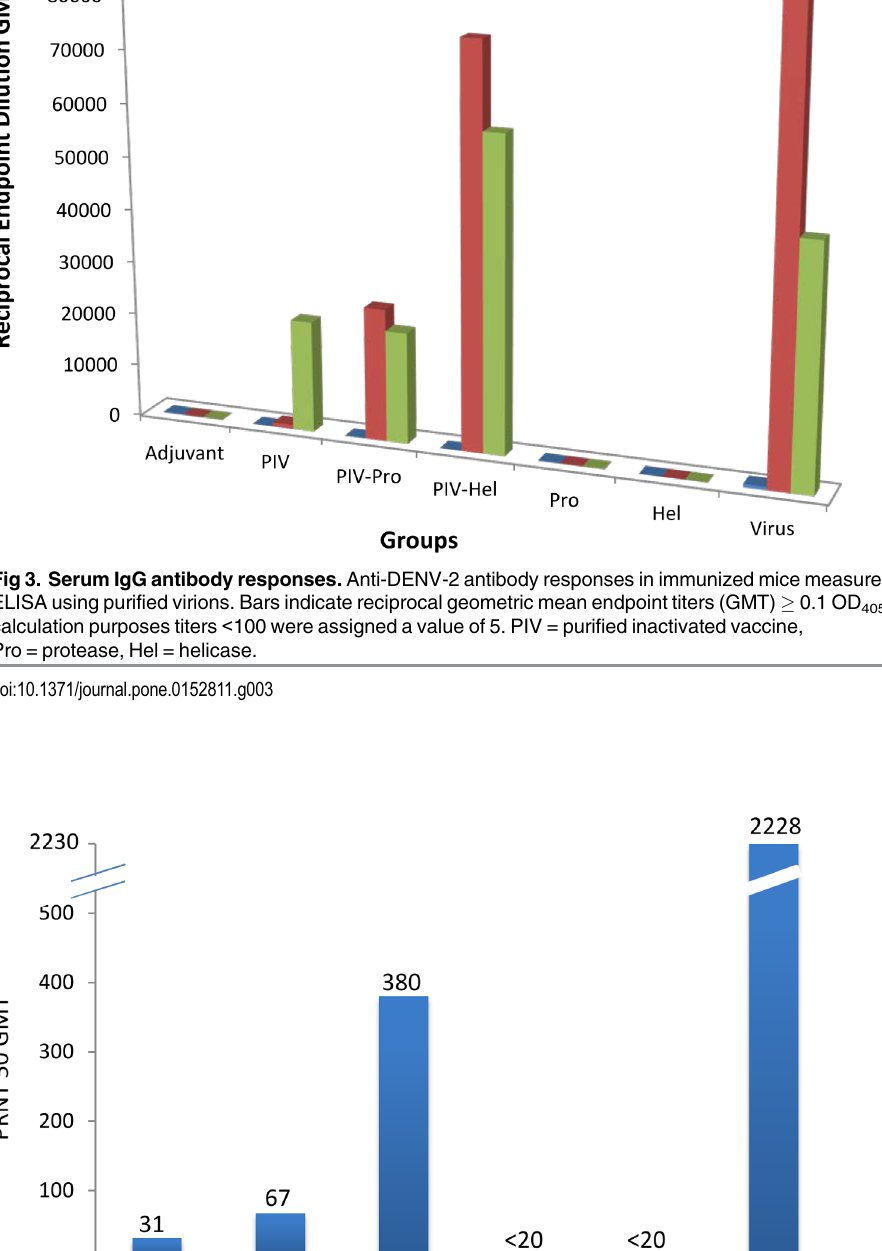
PLOS ONE | DOI:10.1371/journal.pone.0152811 April 1,